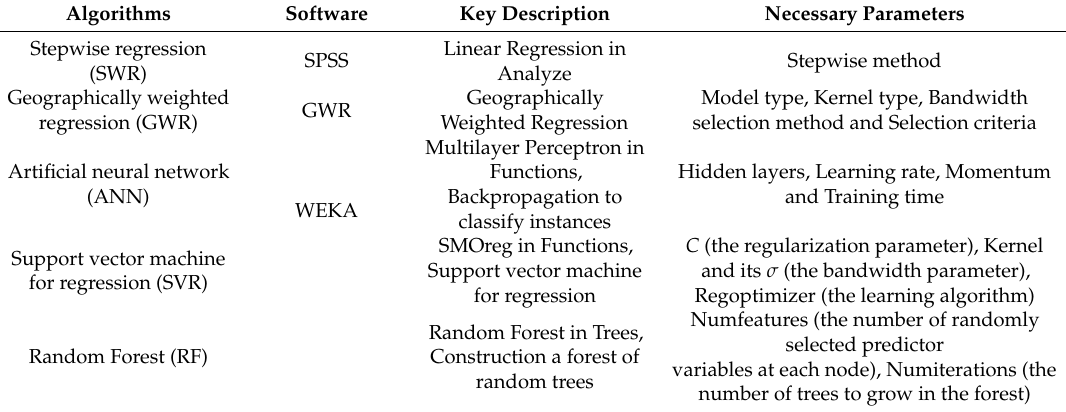
Table 2. Linear regression and machine learning algorithms used in the study. The algorithms are available from SPSS, GWR, and WEKA software